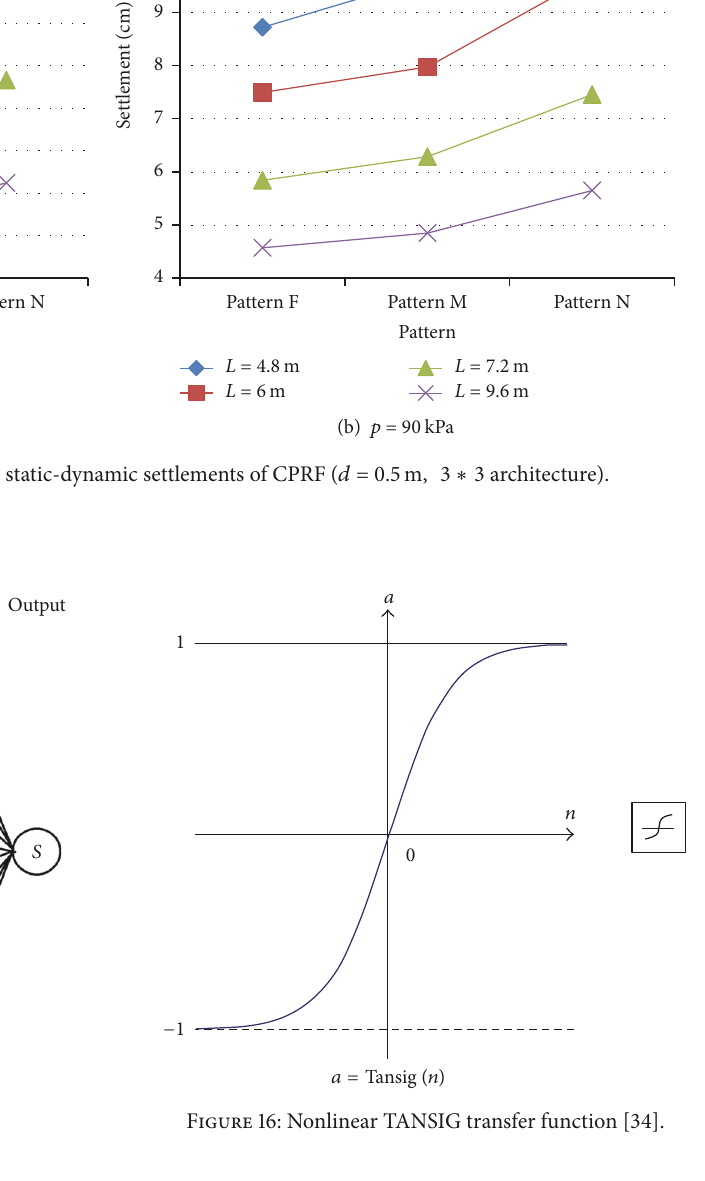
Figure 15: Multilayer perceptron neural network.